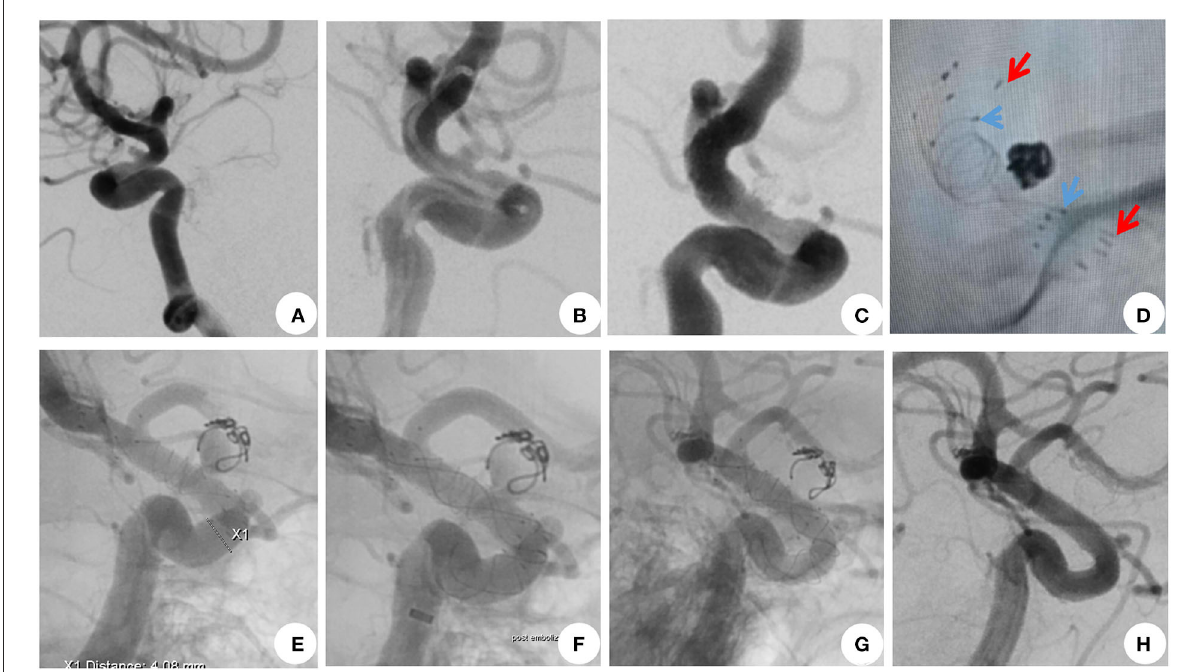
FIGURE1 A 44-year-old woman with recurrent blood blister-like aneurysms (BBAs). (A,B) DSA showed a BBA located at the left supraclinoid segment of the intracranial carotid artery. (C,D) BBA was treated with overlapped LVIS and Enterprise stent-assisted coiling. The immediate postoperative angiogram showed the complete occlusion of the BBA. (E) At 1 month after the initial treatment, DSA showed that the BBA had recurred, and the coils were obviously compressed and dispositioned. (F) Recurrent BBAs were treated with a 4.0 × 25-mm Tubridge, which covered the aneurysm neck, and the stent opened well. (G,H) A 1-month follow-up angiography revealed complete occlusion of BBA and patency of the left intracranial carotid artery. The arrowheads are the ends of the LVIS and Enterprise